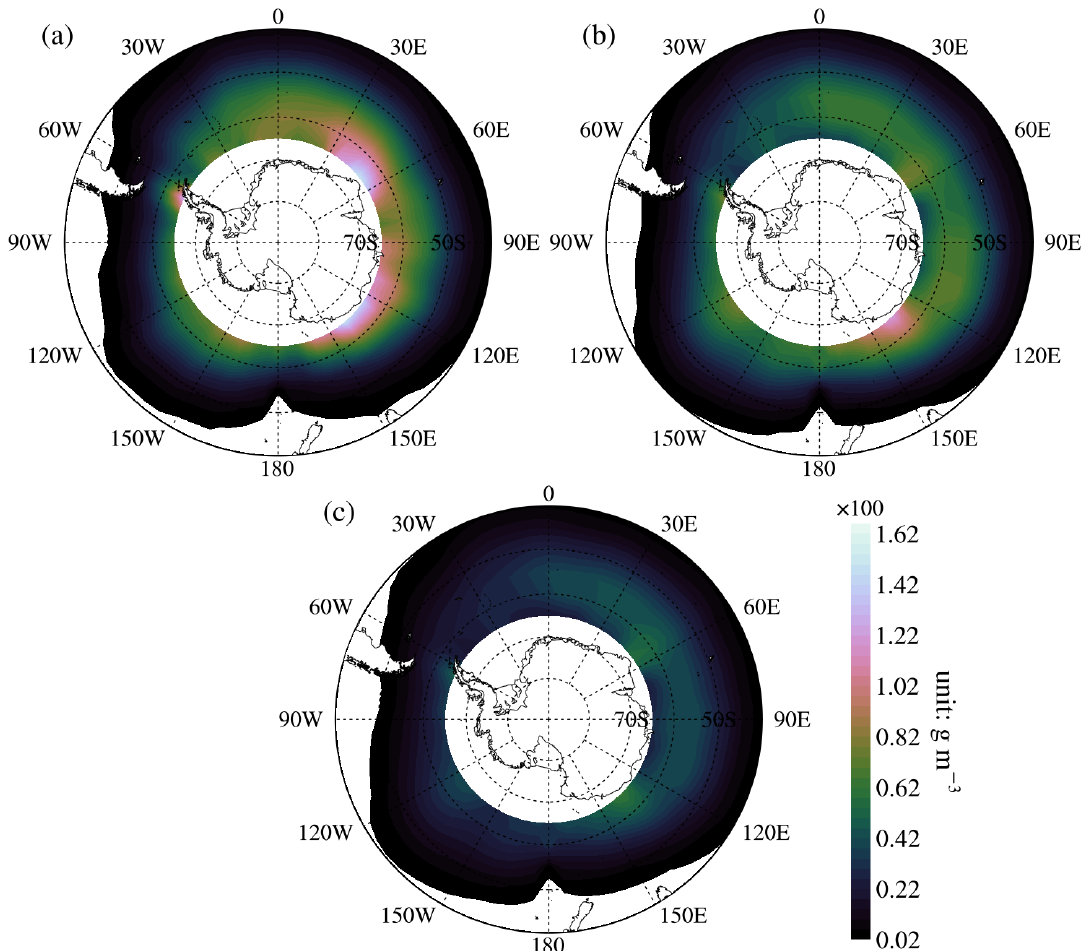
Figure 4. Same as Figure 3 except for southern hemisphere.